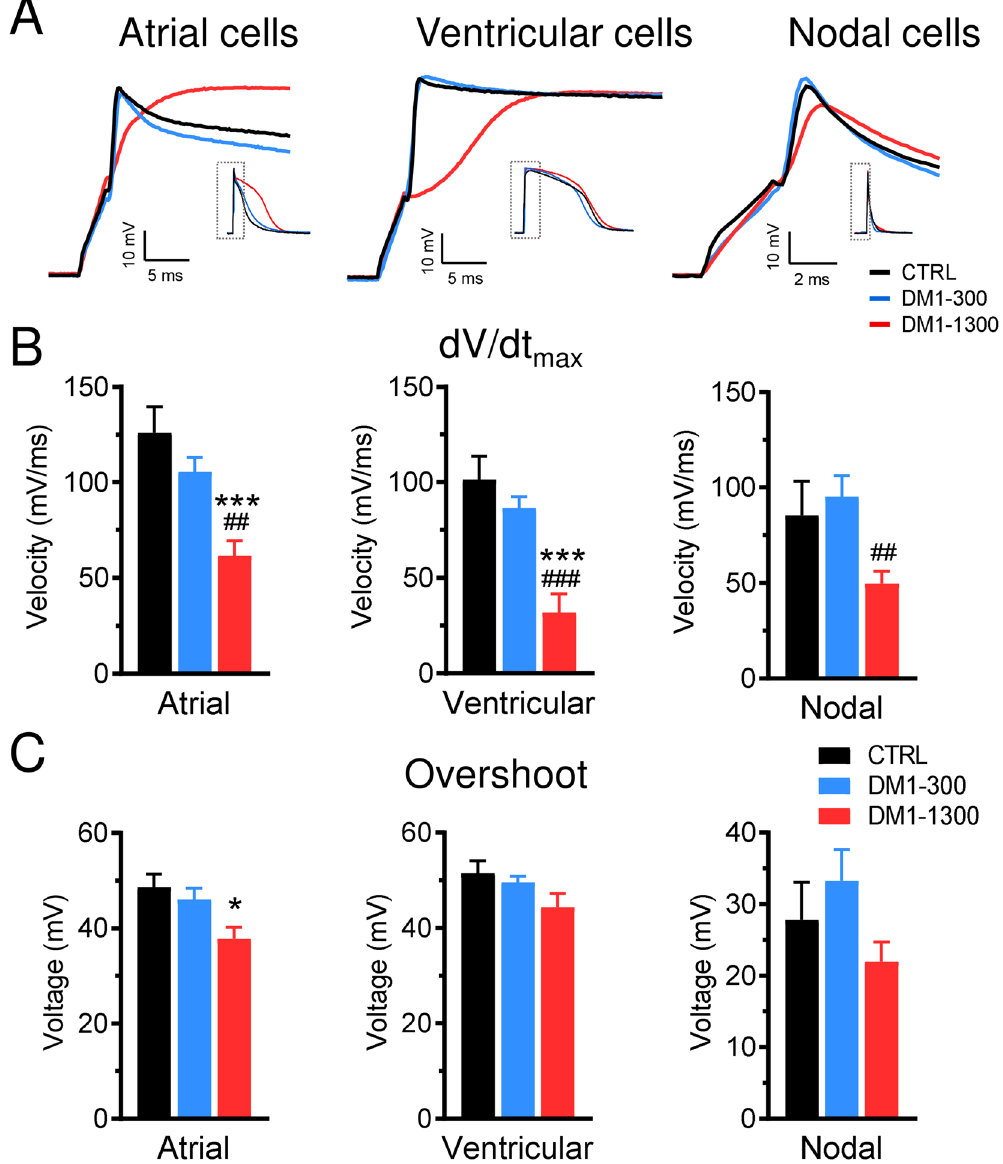
Figure 6. Action potentials dV/dt and overshoot are affected in DM1 iPSC-CMs. ( A ) Close-up view on the rising phase of representative APs recorded at a stimulation frequency of 1 Hz. ( B ) Bar graphs showing the maximal upstroke velocity (dV/dt max ) and overshoot ( C ) of APs recorded in atrial-like (n = 21–23), ventricular- like (n = 12–25), and nodal-like (n = 14–21) cells at a stimulation frequency of 1 Hz. Bars indicate SEM. *p < 0.05, ***p < 0.001 (CTRL vs DM1-1300) and ## p < 0.01, ### p < 0.001 (DM1-300 vs DM1-1300) as determined by ANOVA and Turkey’s post hoc